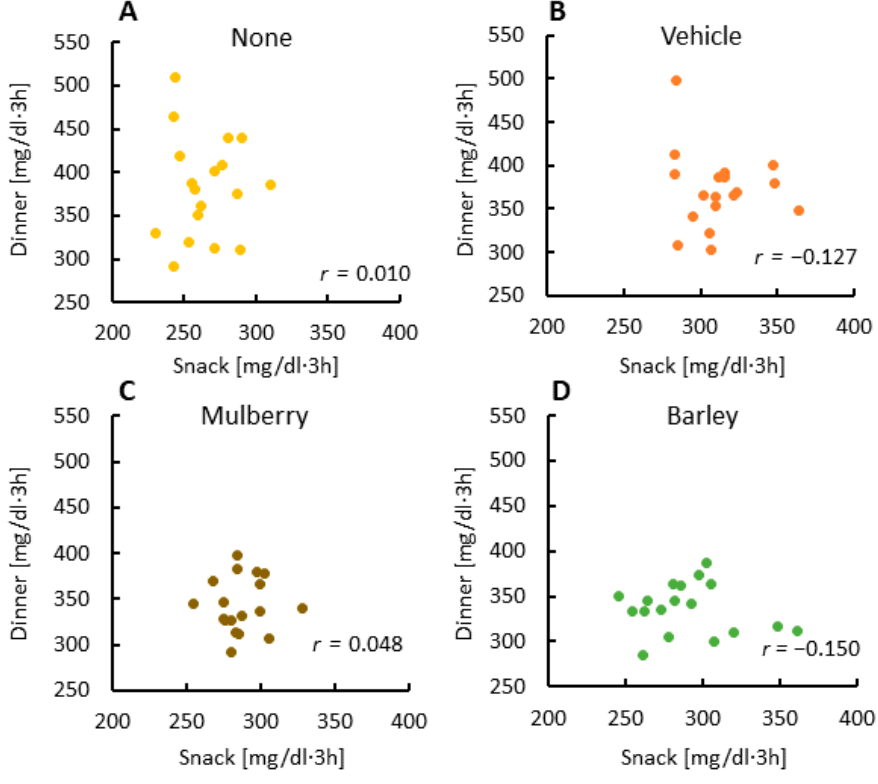
Figure 3. The relationship between area under the curve (AUC) glucose levels at the snack and dinner times for each session. Correlations of glucose AUC between the snack and dinner times for the none group ( A ), correlations of glucose AUC between the snack and dinner times for the vehicle group ( B ), correlations of glucose AUC between the snack and dinner times for the mulberry group ( C ), correlations of glucose AUC between the snack and dinner times for the barley group ( D ).